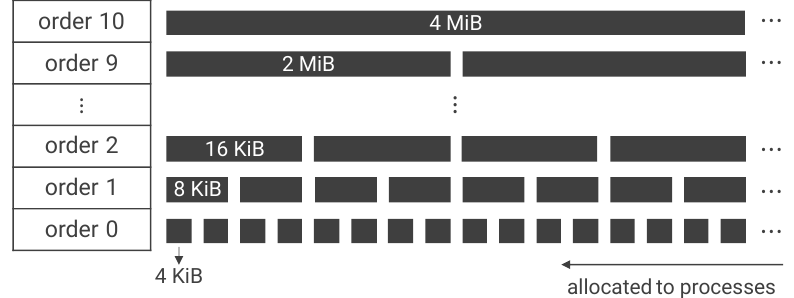
Figure 2. Memory management in Linux via the buddy-allocator algorithm. Memory spaces are divided into orders numbered 0 to 10. Each order is further subdivided into blocks, with the blocks in different orders having different sizes. When a process requests memory allocation, the buddy allocator allocates the smallest block for the required area. Only order 0 requests are allowed from user